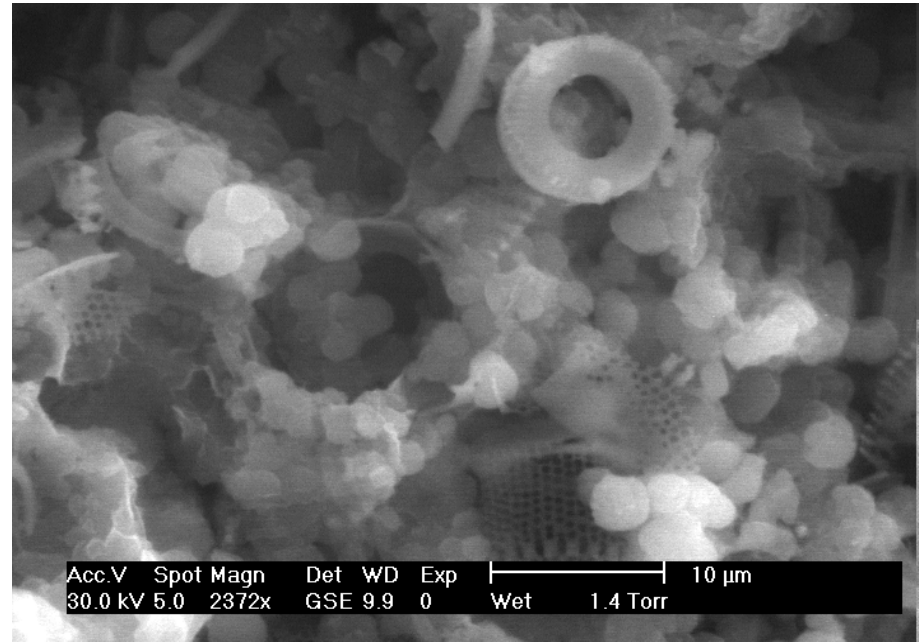
Figure 4. The association of opal-CT micro-plates and lepispheres (i) with diatom frustules. Similar diagenetic changes have been recorded in the volcanic islands of Milos and Aegina, where the opal-A has been diagenetically altered due to the high heat flow rates, related to contemporary volcanism in those islands [35,41].